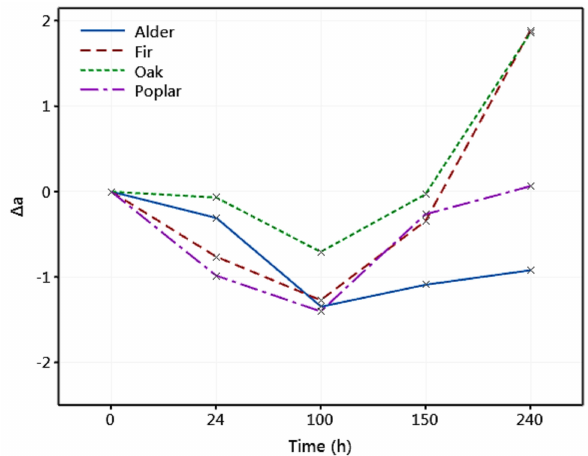
Figure 8. Variation in the redness ( ∆ a ) of different wood species exposed to artificial weathering. Table 1. The mean value and standard deviation of the color change of wood species in different weathering time periods. Wood Time